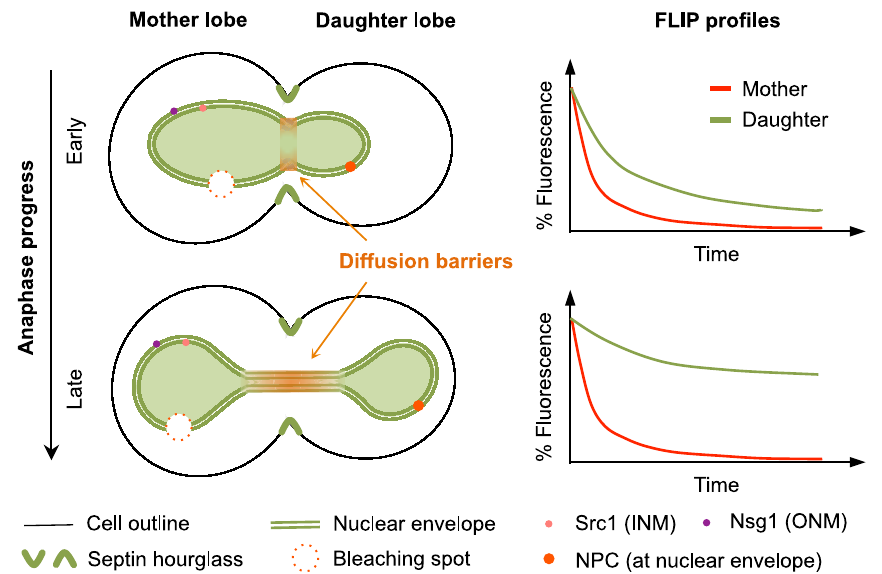
Figure 1. Lateral compartmentalization, assessed by Fluorescence Loss In Photobleaching (FLIP) assays, reflects the diffusion barriers’ strength. The yeast nucleus buds into the daughter cell in early stages of anaphase, elongating into a dumbbell shape in late anaphase. Diffusion barriers have been estimated to locate somewhere between the mother and daughter nuclear halves. Compartmentalization is measured by continuously bleaching the mother lobe while simultaneously measuring the fluorescence decay over time in mother and daughter lobes, separately.